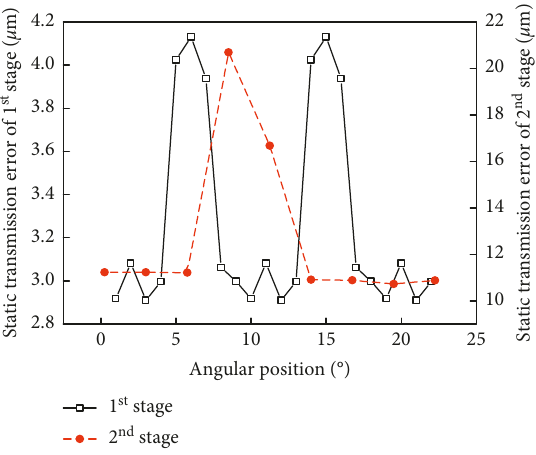
Figure 10: Static transmission error of